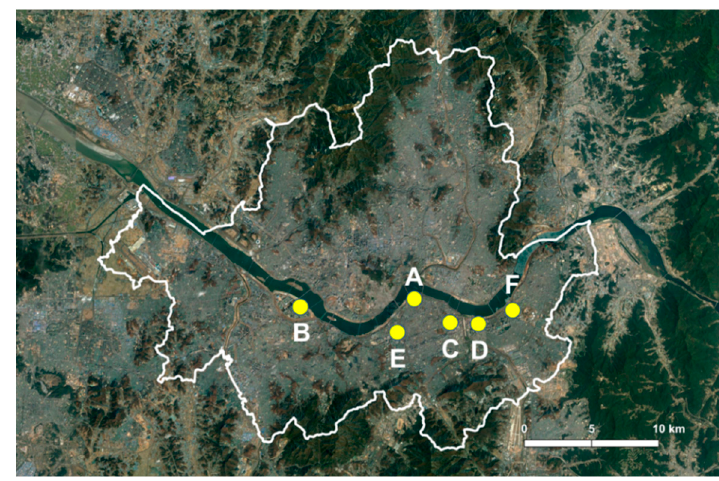
Figure 2. Location of study sites A to F.